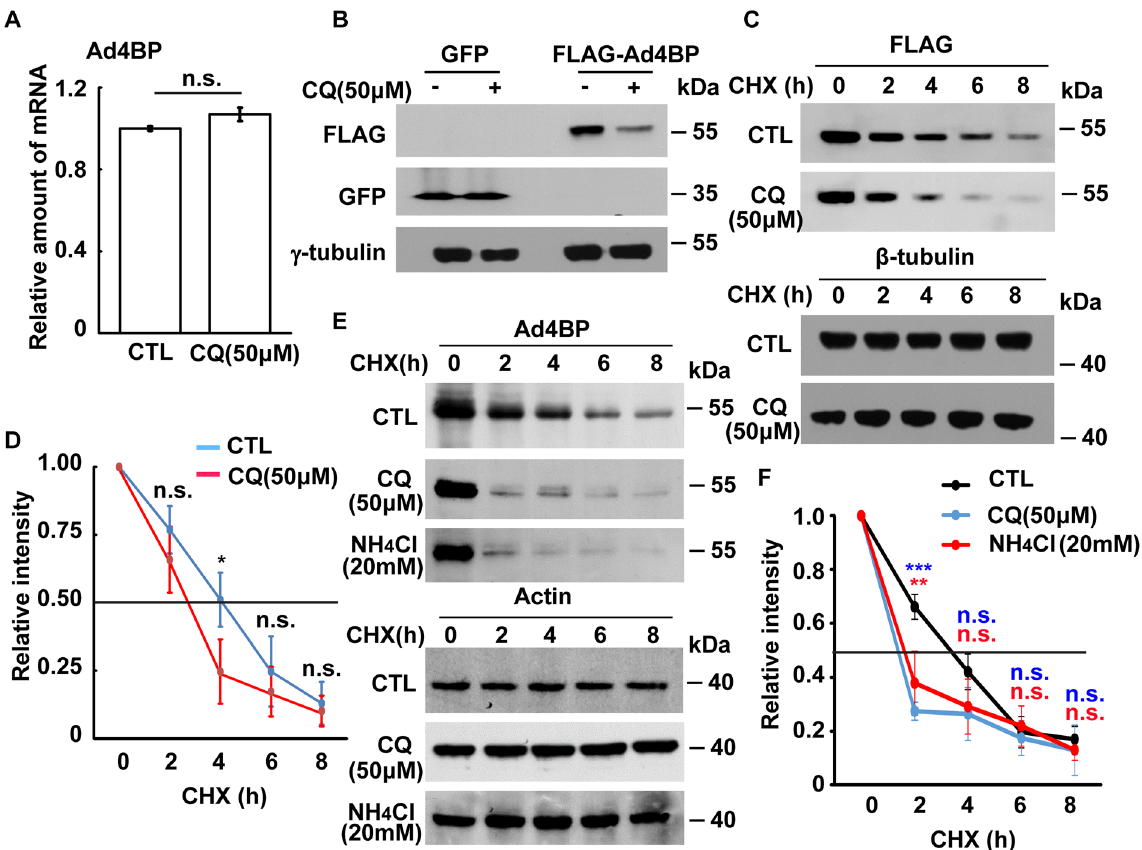
Figure 7. Protein stability of Ad4BP/SF-1 is reduced in CQ-treated Y1 cells. ( A ) CQ treatment does not affect mRNA level of Ad4BP/SF-1. Quantitation of mRNA level of Ad4BP/SF-1 in the presence or absence of CQ (50 μ M). ( B ) Ectopic expressed Ad4BP/SF-1 is reduced in CQ-treated Y1 cells. Whole cell extracts of GFP or 3xFLAG-Ad4BP/SF-1 overexpressed Y1 cells in the presence or absence of CQ (50 μ M) were analyzed by immunoblot with antibodies against FLAG, GFP, and γ -tubulin. ( C – F ) Protein stability of exogenous or endogenous Ad4BP/SF-1 are reduced in CQ-treated Y1 cells. ( C ) Whole cell extracts of 3xFLAG-Ad4BP/SF-1 overexpressed Y1 cells with or without cycloheximide in the presence or absence of CQ (50 μ M) were analyzed by immunoblot with antibodies against FLAG and β -tubulin. ( D ) Quantitation of relative intensity of 3xFLAG- Ad4BP/SF-1 in ( C ); n.s.: no significance; * P < 0.05. ( E ) Whole cell extracts of Y1 cells treated with or without cycloheximide in the presence or absence of CQ (50 μ M) or NH 4 Cl (20 mM) were analyzed by immunoblot with antibodies against Ad4BP/SF-1 (Ad4BP) and actin. ( F ) Quantitation of relative intensity of endogenous Ad4BP/ SF-1 in ( E ); n.s.: no significance; ** P < 0.01; *** P <